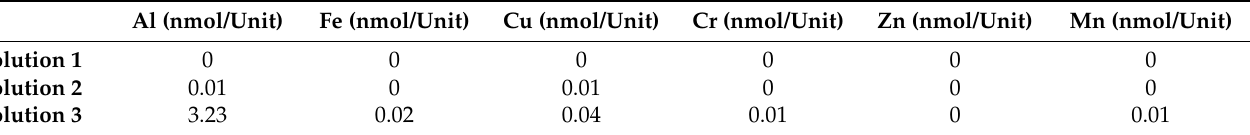
Table 3. Metal concentration (nmol/unit) of the PCR mix before and after reaction process